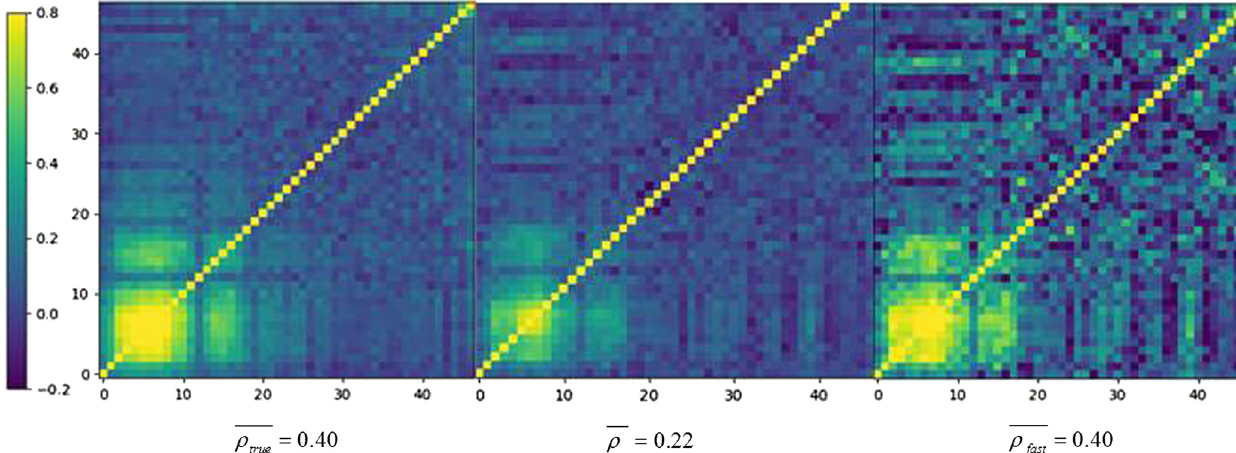
Fig. 1. Results for the synthetic data case. Left: the assumed ND correlation. Middle: the correlation obtained after adding statistics and using the usual Pearson correlation coef fi cient. Right: the correlation obtained after adding statistics and using the fast correlation coef fi